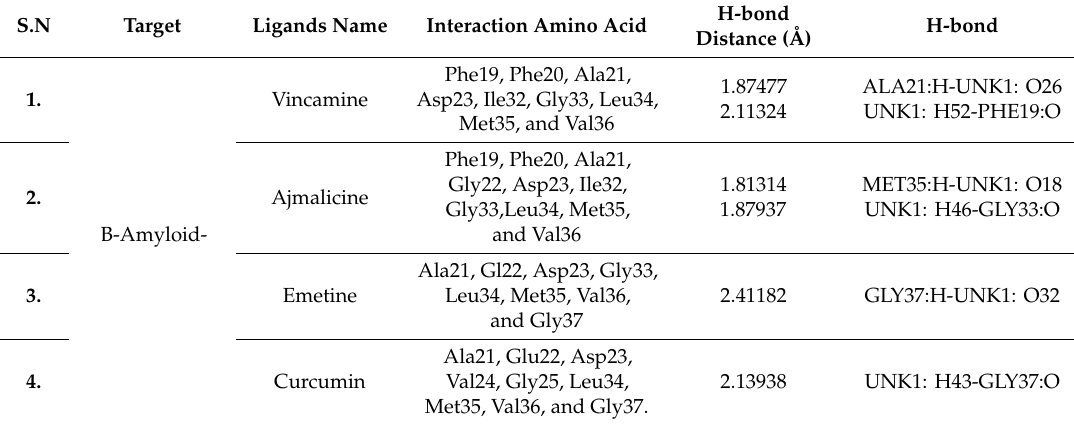
Figure 1. ( A ) The complex shows interacting amino acid residues and hydrogen bonds formed between compound ajmalicine (the ligand, ajmalicine, has been shown in green ‘stick’ representation) and β -Amyloid ( B ) The complex interacting amino acid residues and hydrogen bonds formed between compound emetine (the ligand, emetine, has been shown in green ‘stick’ representation) and β -Amyloid ( C ) The complex interacting amino acid residues and hydrogen bonds formed between compound vincamine (the ligand, vincamine, has been shown in green ‘stick’ representation) and β -Amyloid. ( D ) The complex interacting amino acid residues and hydrogen bonds formed between compound curcumin (the ligand, curcumin, has been shown in green ‘stick’ representation) and β -Amyloid. Table 1. Interacting amino acid residues and the H-bond distance between β -Amyloid and natural